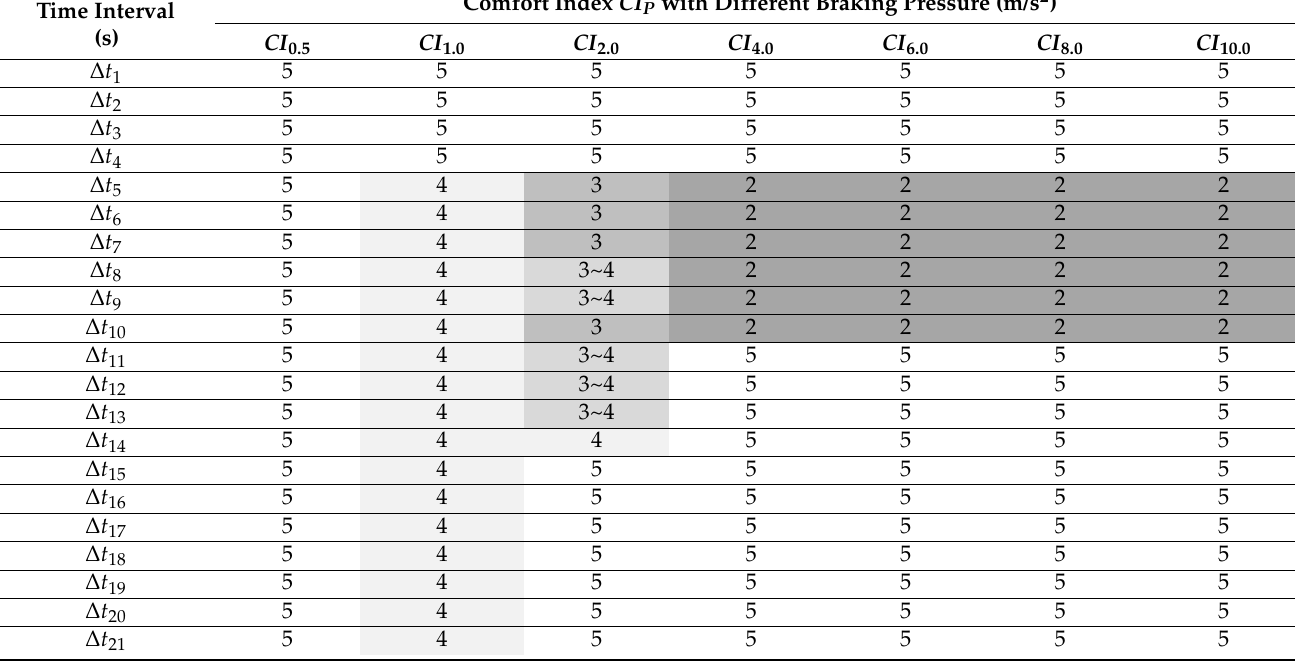
Table 6. Comfort level of emergency braking on a wet